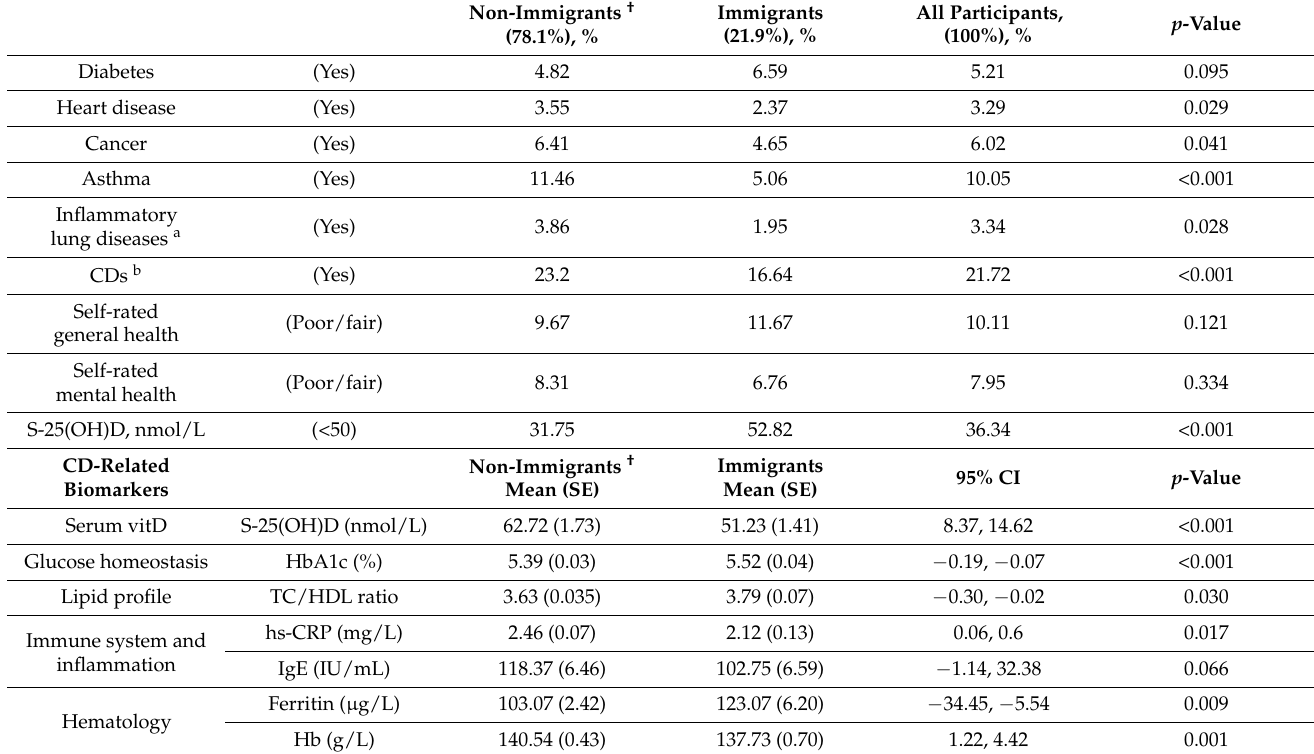
Table 2. Weighted prevalence of chronic diseases, chronic-disease-related biomarkers, and self-rated general and mental health by immigration